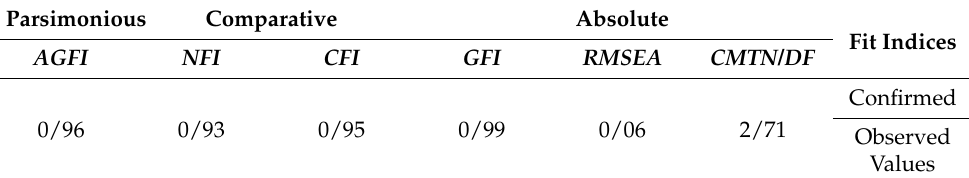
Table 5. Model fit indices. Parsimonious Comparative Absolute AGFI NFI CFI